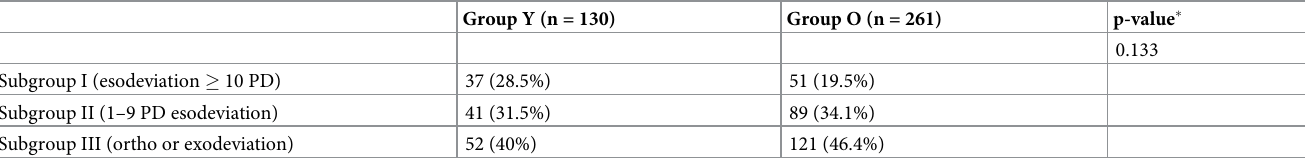
Table 3. Angle of deviation at 1 week postoperatively in groups Y and O.